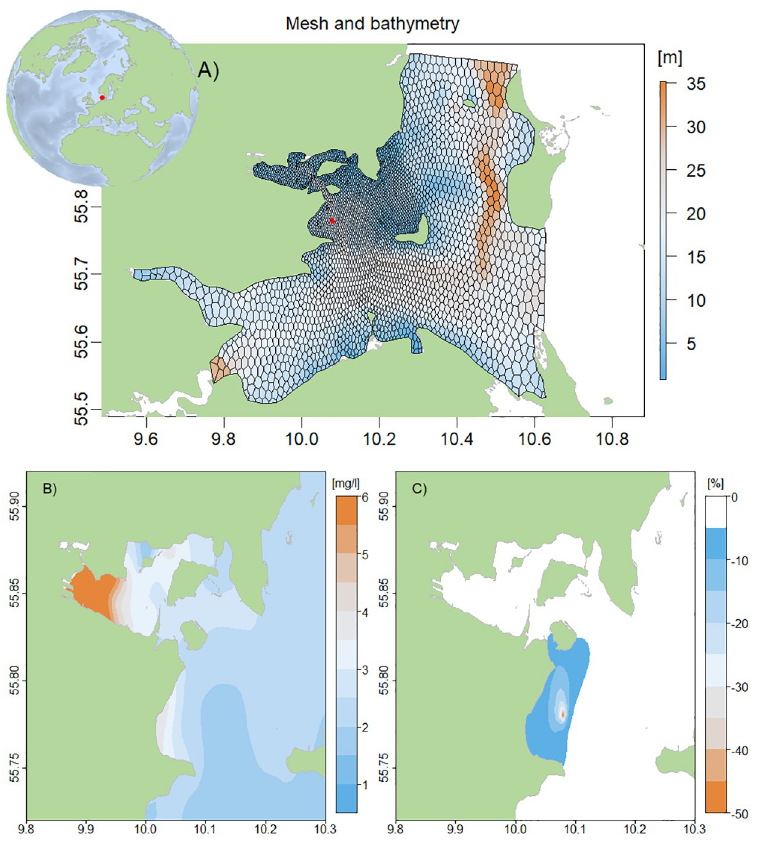
Fig 4. Biogeochemical model—Horsens Fjord area. A) Bathymetry and computational mesh. The red polygon indicates the location of the mussel farm B) average summer Chl a concentrations (mg/l) and C) %-change in Chl-a concentration around the mussel